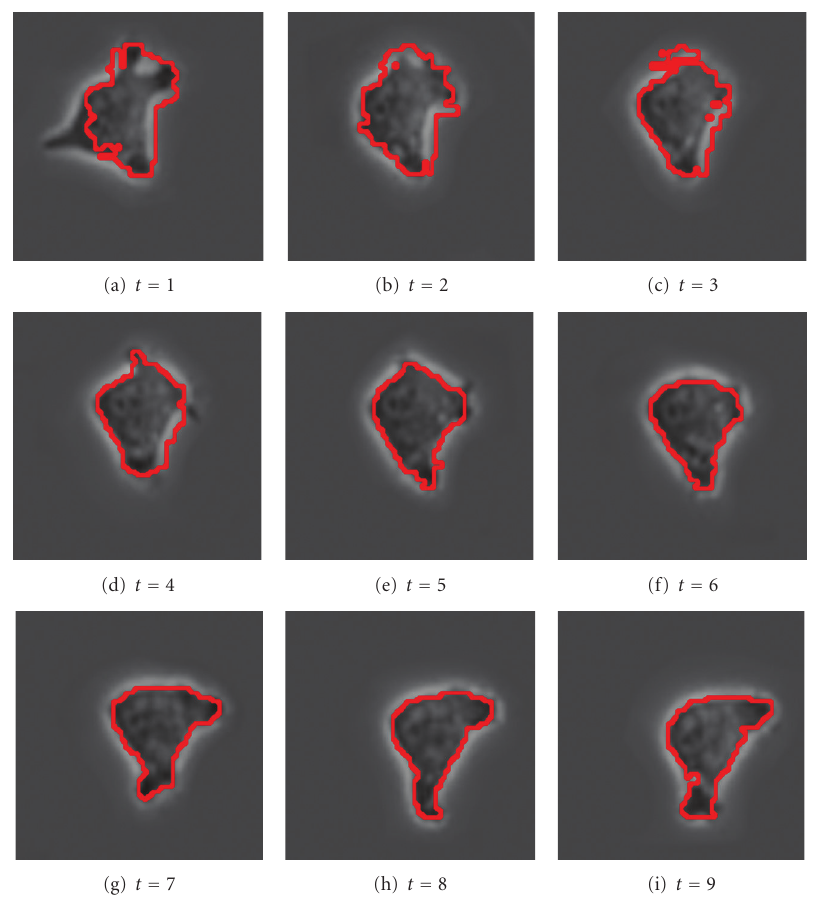
Figure 13: 2 segments found with parameters ( n , α , (cid:7) α , β , θ , γ , d 1 , σ , ρ ) = (60,100,5,160,0 . 0055,0 . 062,0 . 15,5,2).